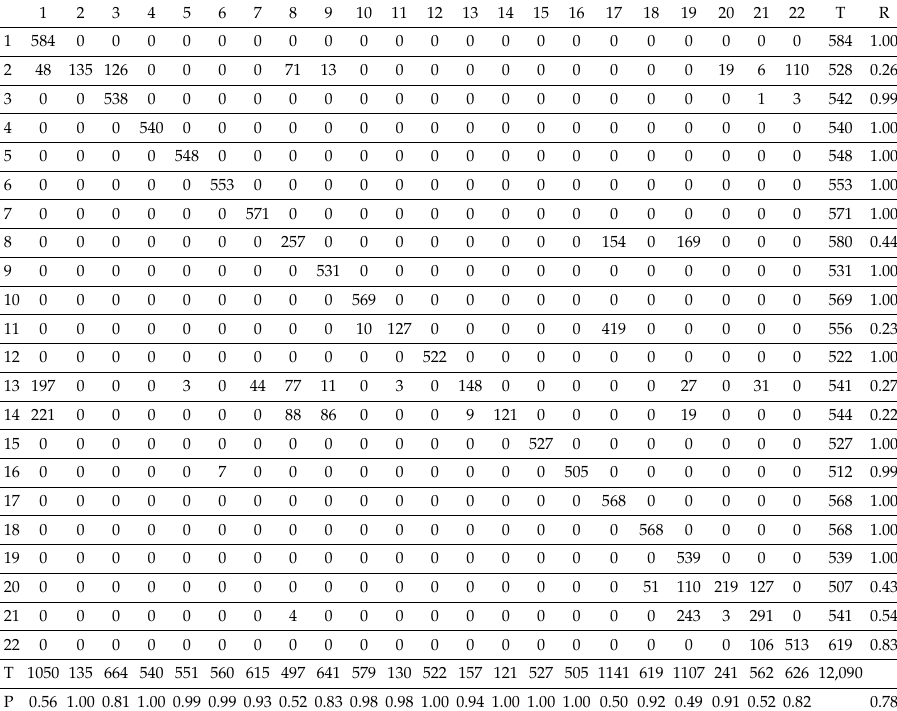
Table A1. The confusion matrix of the DAP [7]. The numbers in the first row and the first column correspond to the pose IDs shown in Table 1. T denotes total number in rows and columns. P and R denote precision and recall, respectively. The number in the bottom right is the accuracy (sum of diagonal elements divided by the total numbers). Please note that this is different from the F-measure.